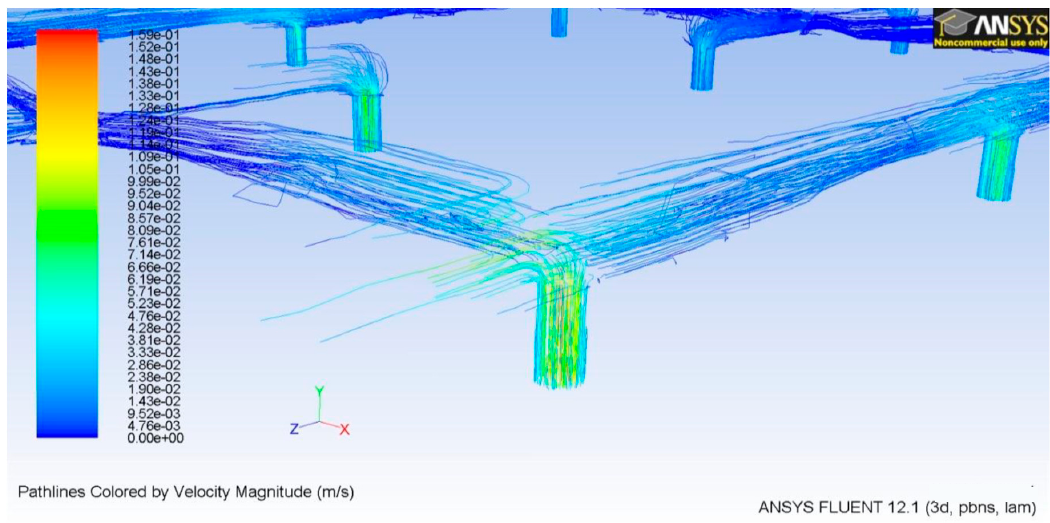
Figure 8. Cross sectional view of the discharge process.